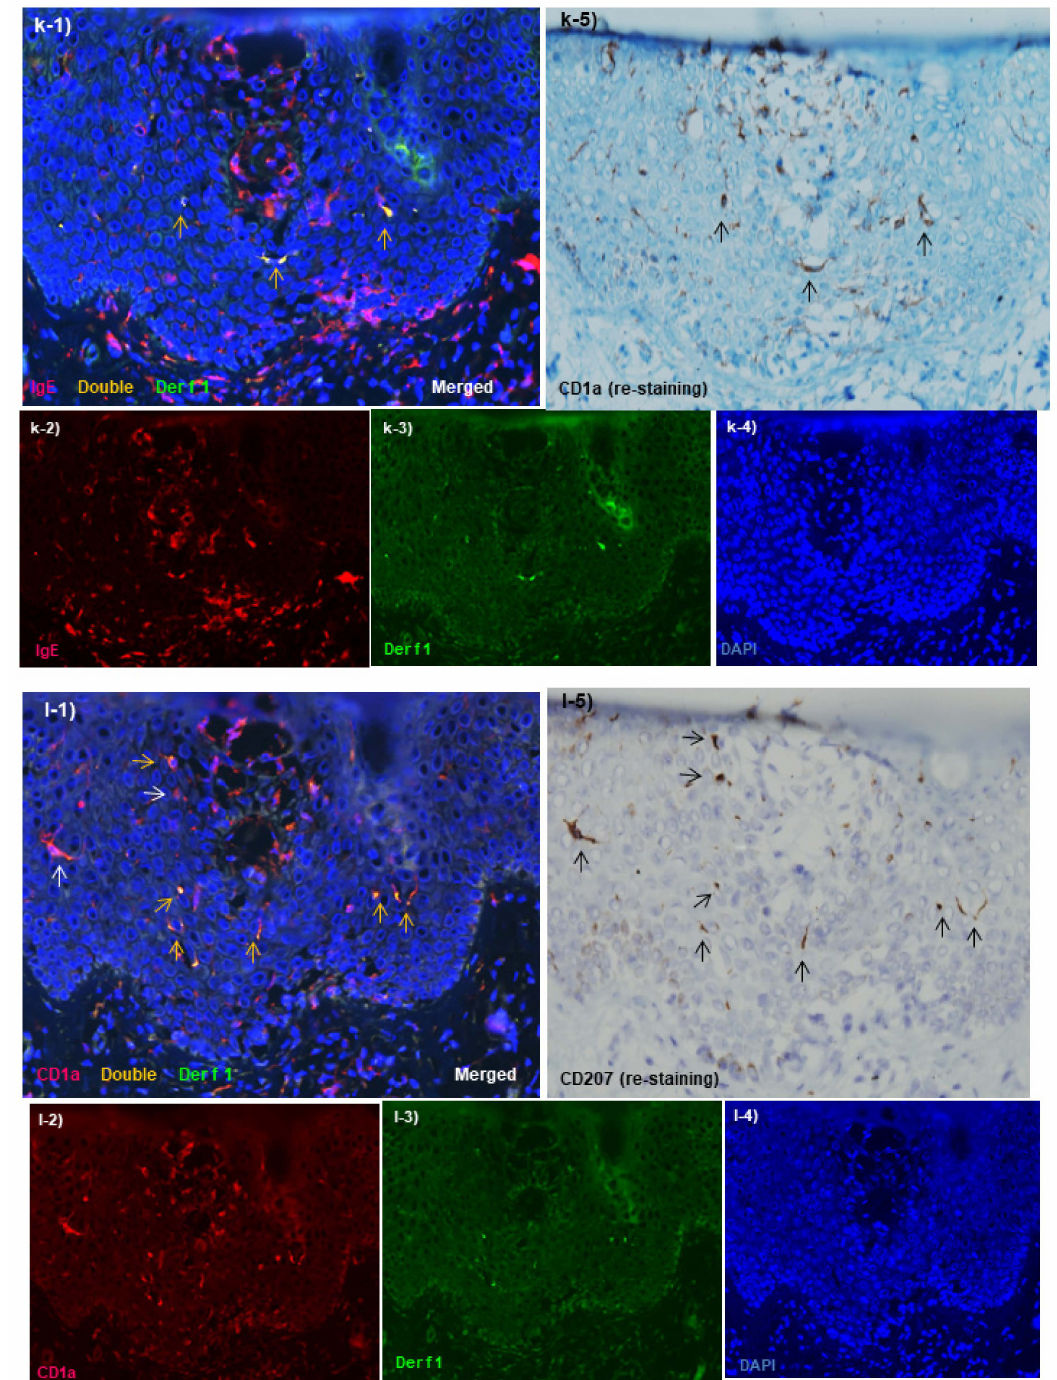
Figure 3. Immunohistopathology of skin manifestations of IgE-allergic AD. ( a ). Uninvolved skin: Regularly arranged IgE+ CD207+ LCs (red images of a-1 that colocalize with brown images of a-5 ), but not infiltrated IgE+ CD11+ IDECs (yellow image of a-1 ), are observed in the epidermis. Infiltration of IgE+ CD11+ inflammatory DCs (yellow images of a-1 ) in the upper dermis is slight. Note that the dendrites of LCs are not stained with CD207 ( a-1 , a-5 ).( b ). Uninvolved skin: Few HDM antigens captured by IgE + LCs in the epidermis and by IgE+ infiltrating cells in the upper dermis are observed. ( c ). Lichenified eczema; non-spongiotic dermatitis: In the epidermis, IgE+ CD207+ LCs (red images of c-1 that are colocalized with the brown images of c-5 ) are located in the upper-middle layer, and IgE+ CD11+ IDECs (yellow images of c-1 ) are located in the lower layer. LCs without IgE expression (brown images of c-5 that are not colocalized with the red images of c-1 ) are also observed in